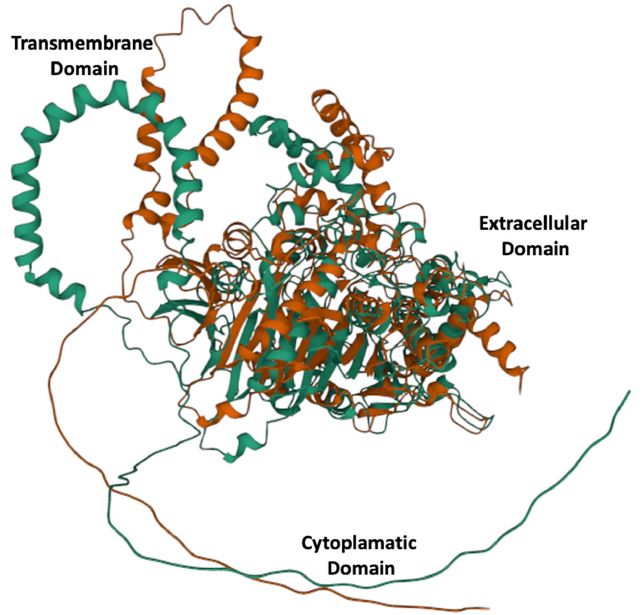
Figure 1. Three ‐ dimensional alleles models for E215 green and K215 red. A significantly different structural configuration is obtained by a single radical amino acid substitution at position 215.